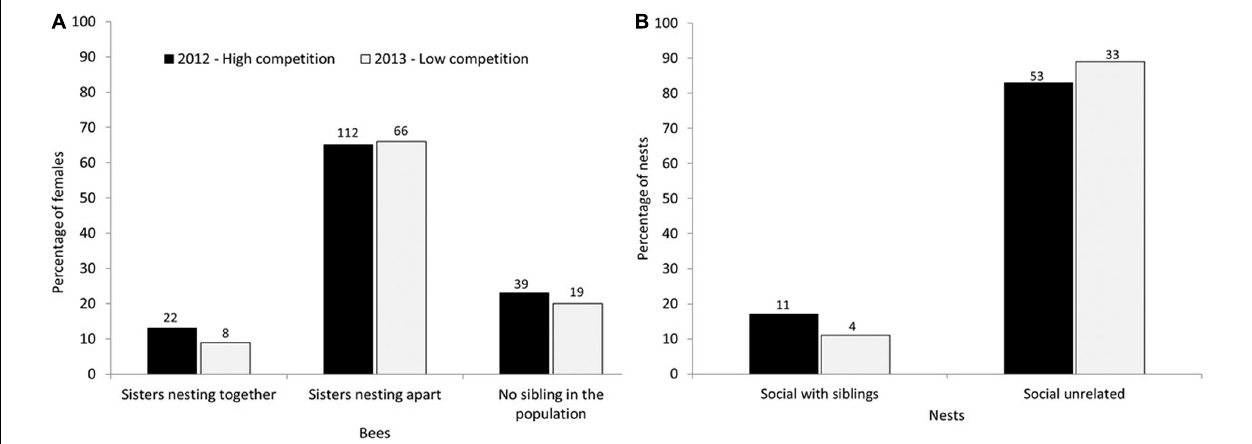
FIGURE 3 | Evidence for avoidance of competition by adult females during the brood provisioning period. (A) Although many females had at least one full sister in the population, most females nested apart from their sisters, rather than remaining together in the natal nest or dispersing together to a new nest. The proportions of sisters nesting together or apart did not differ between 2012 and 2013 ( X 2 = 1.38, d.f. = 2, P = 0.50), suggesting that changes in population density did not influence the relatedness structure of colonies. (B) The proportion of social colonies that contained full sisters was also similar in 2012 and 2013 (Fisher’s exact test, P = 0.48). Numbers above the bars represent the number of individuals (A) or nests (B)